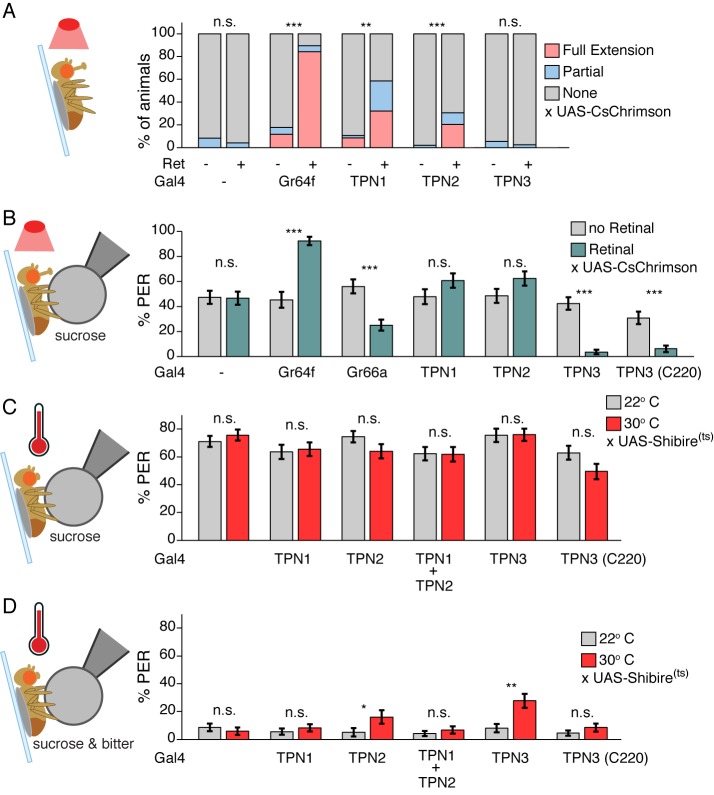
Taste projection neurons influence proboscis extension.(A) PER to activation with CsChrimson, in absence of a taste stimulus. Activation of sugar GRNs (Gr64f), TPN1, and TPN2 increase PER, compared to no retinal controls. For Gal4 control and Gr64f-Gal4, n = 17–24. For TPNs, n = 38–53. Fisher’s exact tests, **p<0.01, ***p<0.001. (B) PER to simultaneous CsChrimson activation and 100 mM sucrose presentation. Strong enhancement of PER was observed upon sugar GRN activation, but not TPN1 or TPN2 activation. Strong suppression of PER was observed for both bitter GRN (Gr66a) and TPN3 activation. PER suppression by TPN3 was observed with both Gal4 drivers. n = 42–58. Error bars indicate mean +/-± SEM. Wilcoxon rank-sum tests, ***p<0.001. (C) TPNs were conditionally silenced with Shits and PER was tested to a sweet solution (100 mM sucrose). Silencing TPNs did not affect PER to sweet solutions. n = 50–63. Error bars indicate mean +/-± SEM. Paired Wilcoxon tests. (D) TPNs were conditionally silenced with Shits and PER was tested to a sweet-bitter mixture (100 mM sucrose, 25 mM caffeine, and 0.5 mM denatonium). Small increases in PER rate in some experiments were not consistently found across conditions. n = 50–63. Error bars indicate mean +/-± SEM. Paired Wilcoxon tests, *p<0.05, **p<0.01.